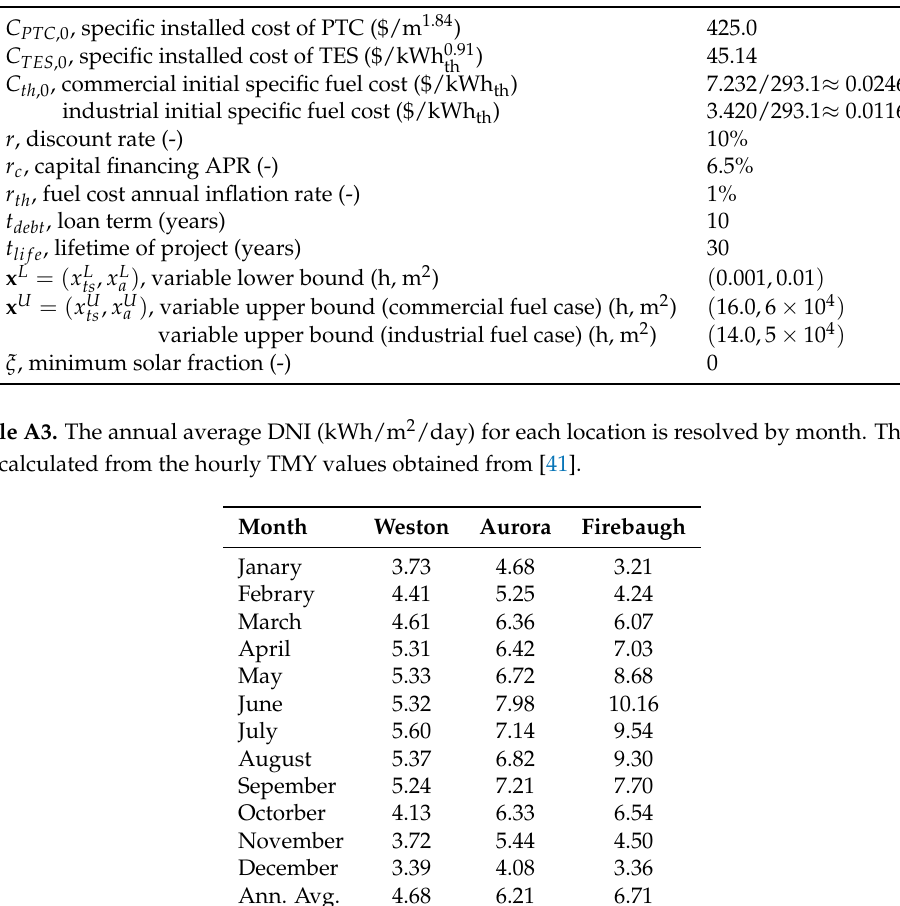
Table A2. The economic modeling and optimization parameters.